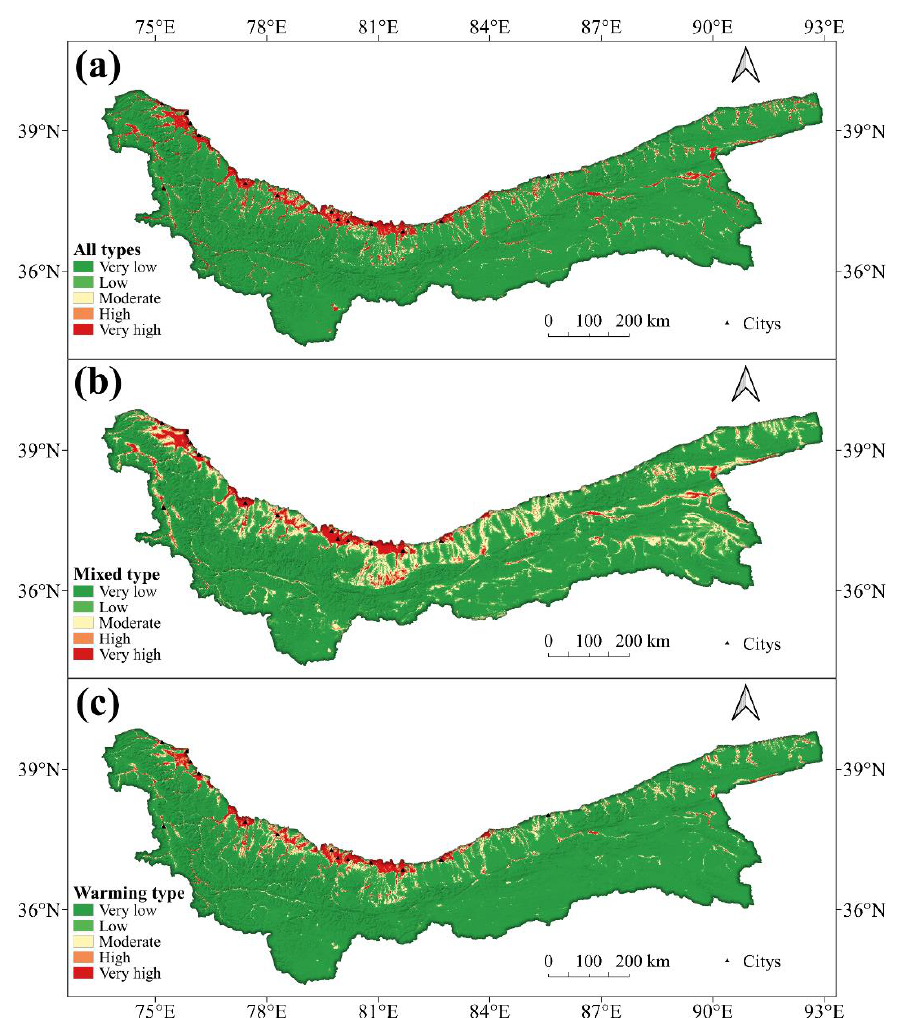
Figure 8. Snowmelt flood susceptibility in Kunlun Mountains: ( a ) all types, ( b ) mixed type and ( c ) warming type.